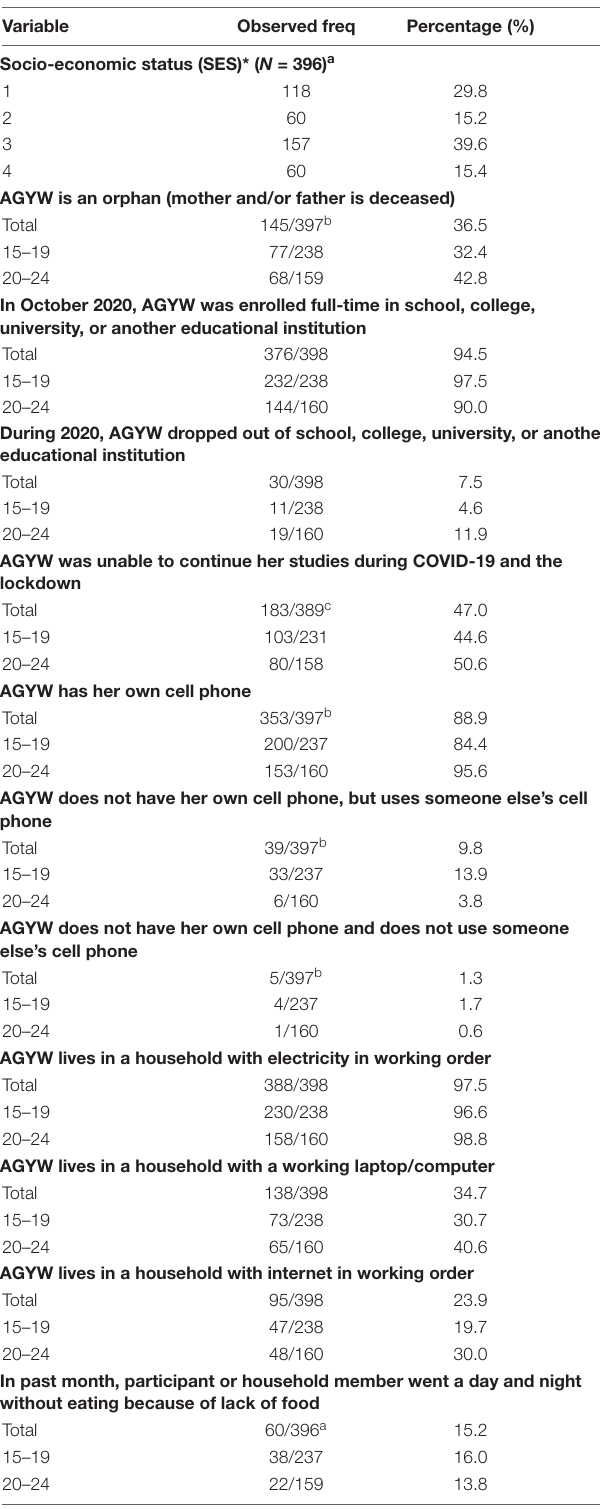
TABLE 1 | Description of survey participants who were enrolled full-time in an educational institution at the beginning of the 2020 academic year ( N = 398).